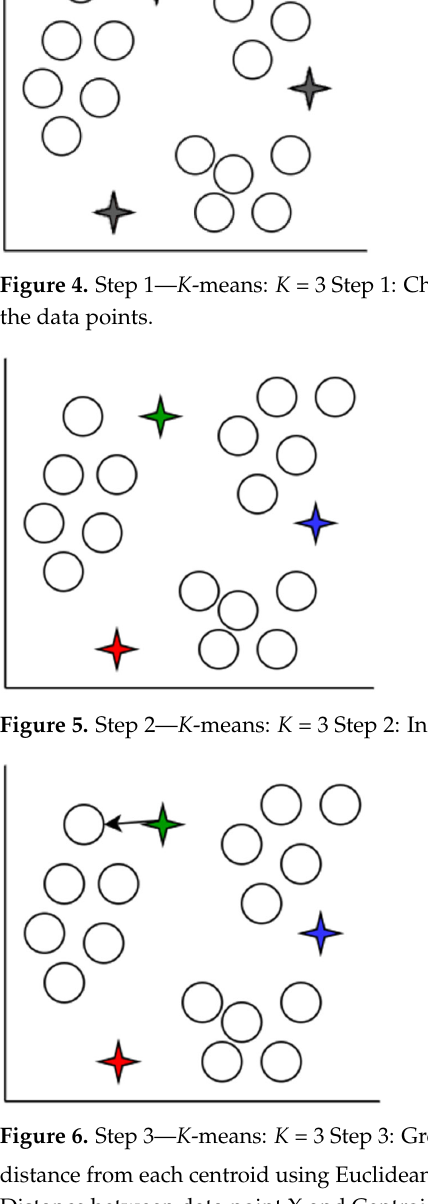
Figure 7. Step 4— K ‐ means: K = 3 Step 4: Data point added to its nearest cluster.